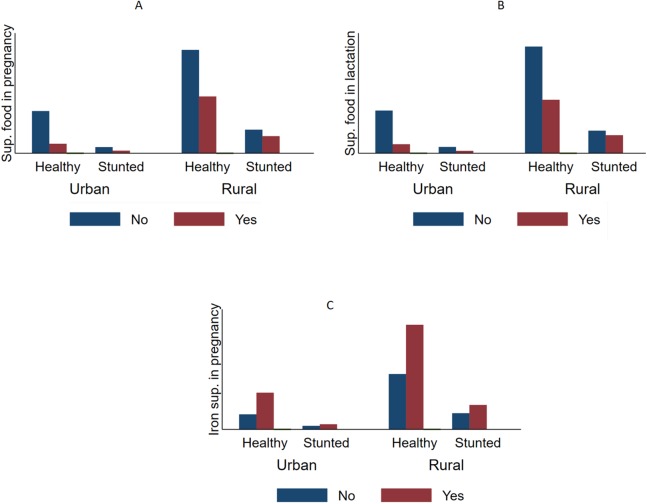
Comparative prevalence of stunting by supplementation intake during pregnancy and lactation stratified by type of residency in Timor Leste (2009–2010).The prevalence of stunting (HFA < 2 SD) according the supplementary food intake status among urban and rural mothers. The figure indicates that mothers who took supplementary food during pregnancy (A) and lactation (B) had lower likelihoods of having stunted children compared with those who did not. This was true in both urban and rural areas. Taking iron supplementation (C) appeared to have a positive relationship with stunting; however, the difference was not statistically significant.